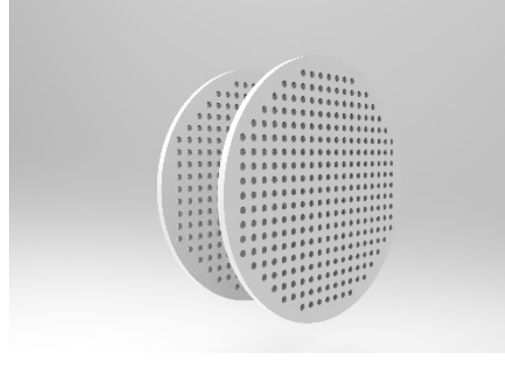
Figure 3. The specific structure of the sensor array with six SnO 2 gas sensors.